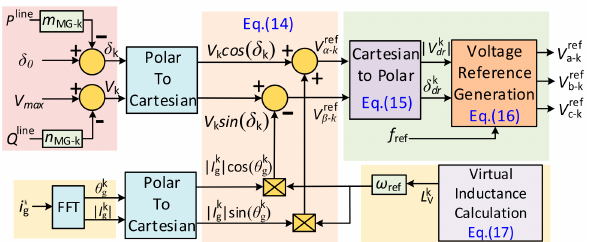
Figure 8. Modified angle-voltage droop control employed for the LSC during HMG operation.